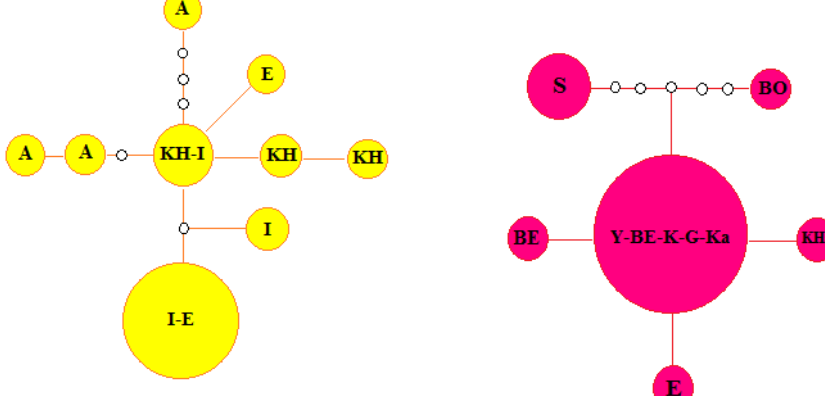
F IGURE 12. Haplotype network of Jaculus (32 individuals), based on 626 bp of the Cytochrome Oxidase subunit I gene (Cox1). Networks were not joined if haplotypes were separated by more than 9 mutations. Each circle represents one haplotype. (Yellow circles: J. jaculus : A: Abadan, I: